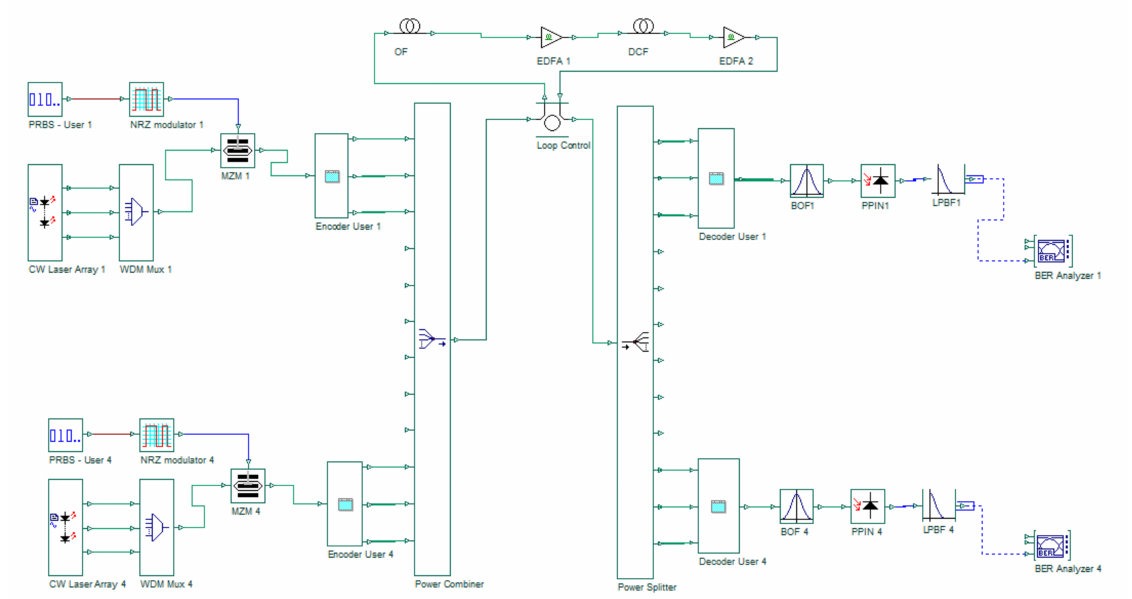
Figure 6. Simulation setup of 2D-MD SAC-OCDMA system supporting four users (MZM: Mach-Zehnder Modulator, OF: Optical Fiber, DCF: Dispersion Compensating Fiber, EDFA: Erbium Doped Fiber Amplifier, BOF: Bessel Optical Filter, PPIN: Photodiode PIN, LPBF: Low Pass Bessel Filter).